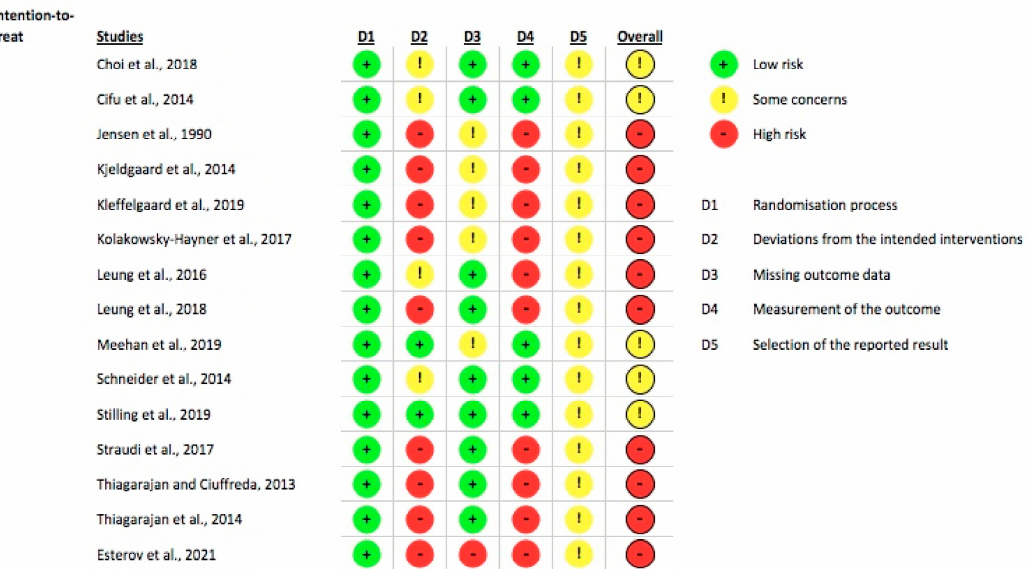
Figure A3. Risk of Bias for each study included in the Section 3.3, assessed using the Cochrane Rob2 tool revised version [35,41–53,55].